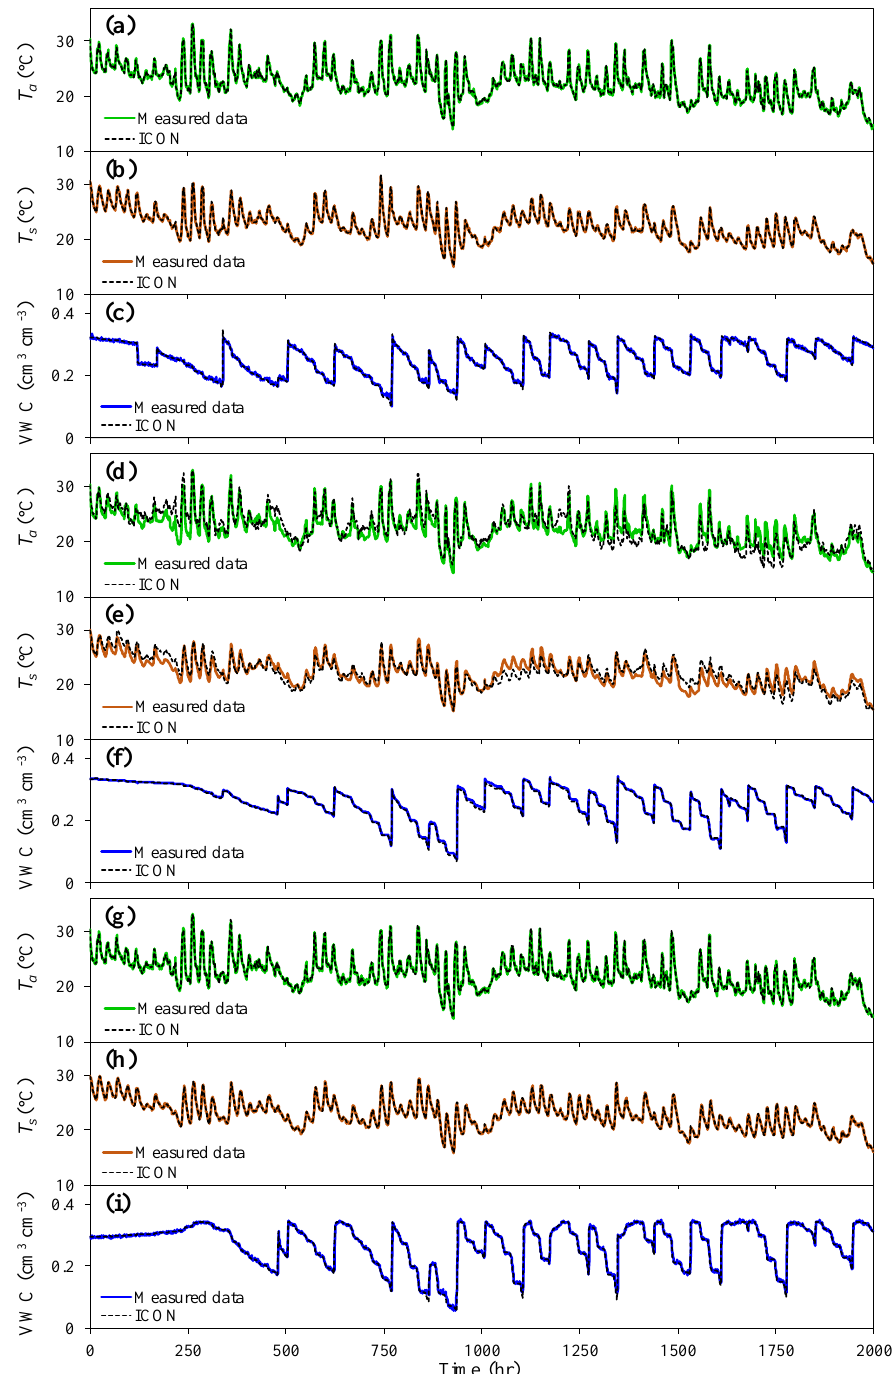
Figure 9. The interaction factors used to establish the ICON model with the training set: ( a , d , g ) air temperature ( T a ), ( b , e , h ) soil temperature ( T s ), and (c,f,i) volumetric water content (VWC) in baskets ( a – c ) No. 12, ( d – f ) No. 13, and ( g – i ) No. 14.